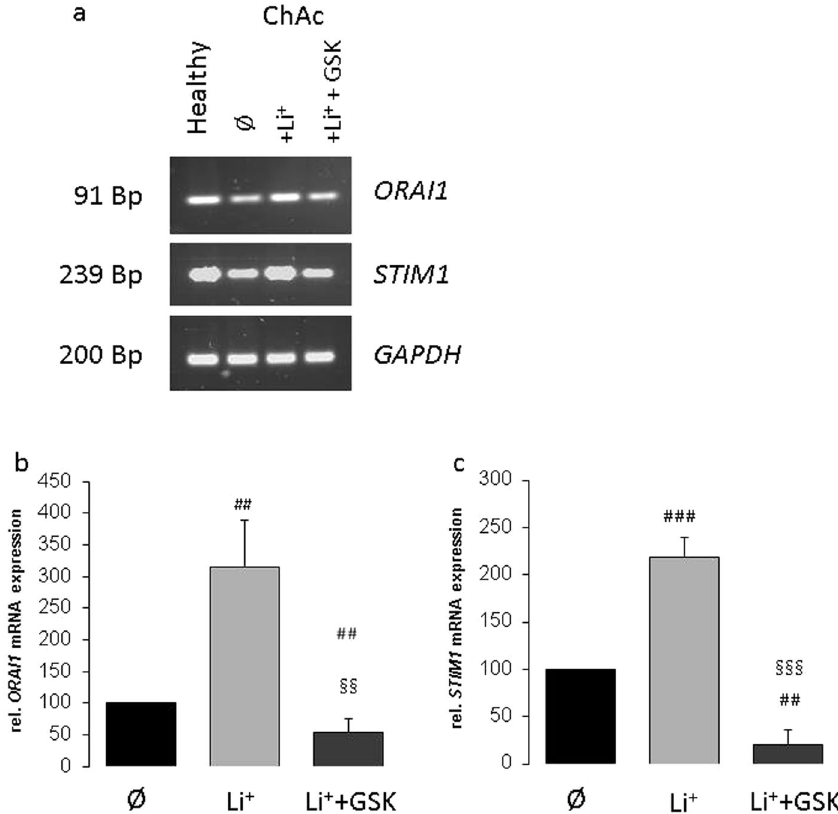
Figure 2. Effect of lithium treatment without and with SGK1 inhibitor GSK650394 on ORAI1 and STIM1 transcript levels in ChAc neurons. ( a ) Original gels illustrating specificity of PCR products. ( b , c ) Arithmetic means ( ± SEM, n = 5) of ( b ) ORAI1 and ( c ) STIM1 transcript levels in neurons generated from ChAc patients without (black bars) or with lithium (24 h, 2 mM) treatment without (light grey bar) and with (dark grey bar) presence of SGK1 inhibitor GSK650394 (10 µ M). ## (p < 0.01), ### (p < 0.001) indicates statistically significant difference to respective value in the absence of lithium treatment. §§ (p < 0.01), §§§ (p < 0.001) indicates statistically significant difference to respective value in the absence of